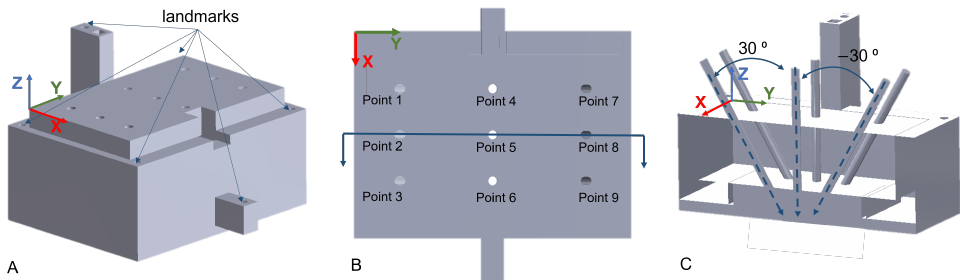
Figure 5. ( A ) Side view of the phantom and the six landmarks used for phantom registration; ( B ) top view of the phantom with the nine target ID used during the experimental validation; ( C ) section view of the phantom along the line in ( B ).